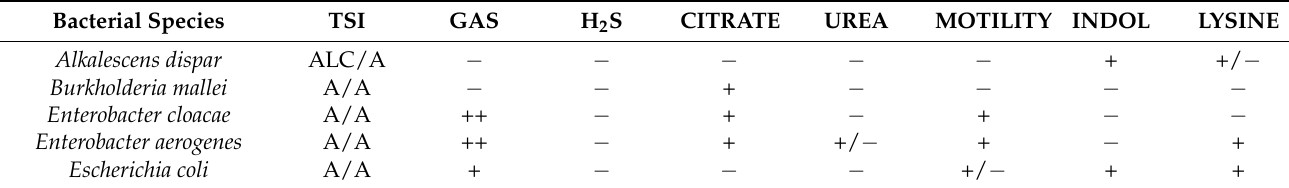
Table 1. Bacterial species identified according to their biochemical